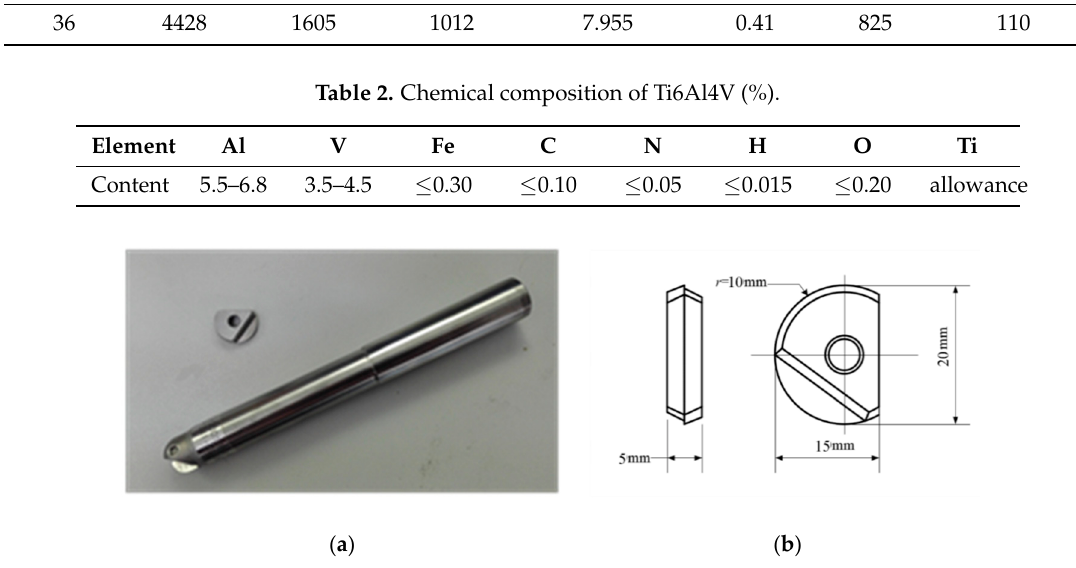
Figure 4. The tool shank and insert. (a) Physical graph; (b) dimensional figure.